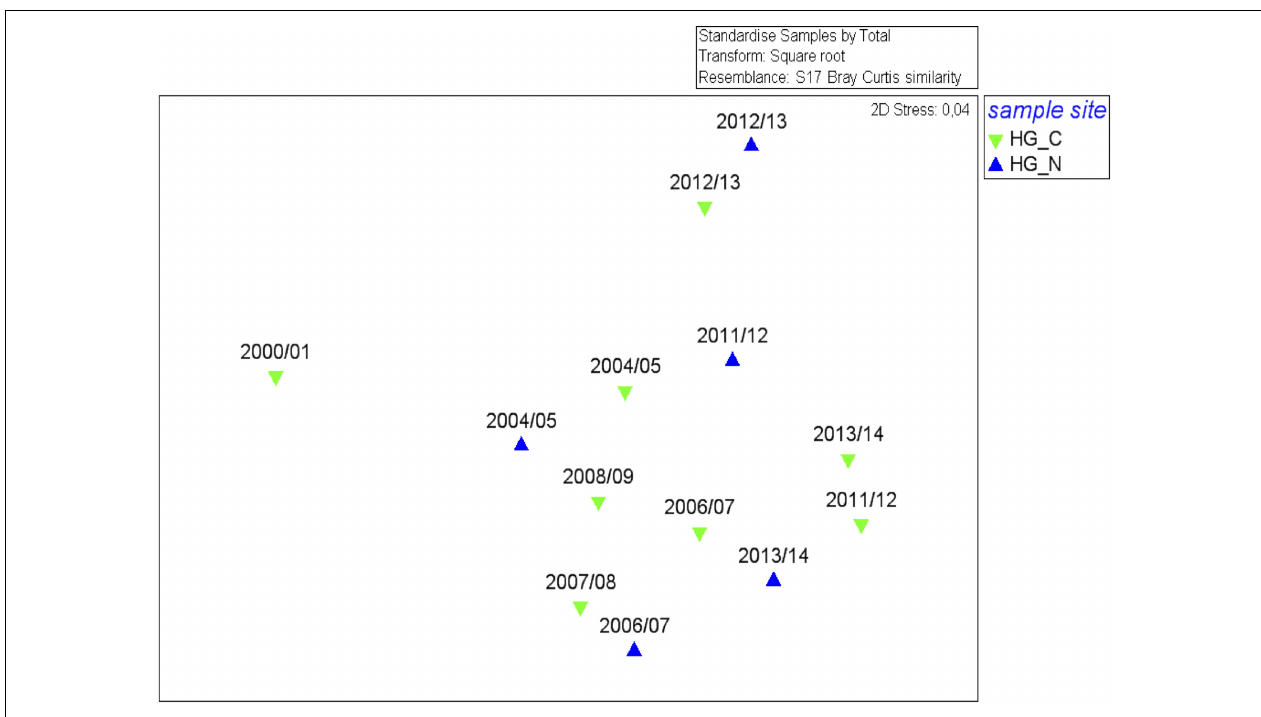
FIGURE 5 | Multi-Dimensional Scaling plot of mean amphipod abundances (Ind.m − 2 d − 1 ) in HAUSGARTEN sediment traps (2000–2014) based on the Bray Curtis similarity measure. Blue upright triangles indicate the northern sampling locations, green inverted triangles represent the central moorings. Data ranging from 2000 to 2009 were obtained and analyzed by Kraft